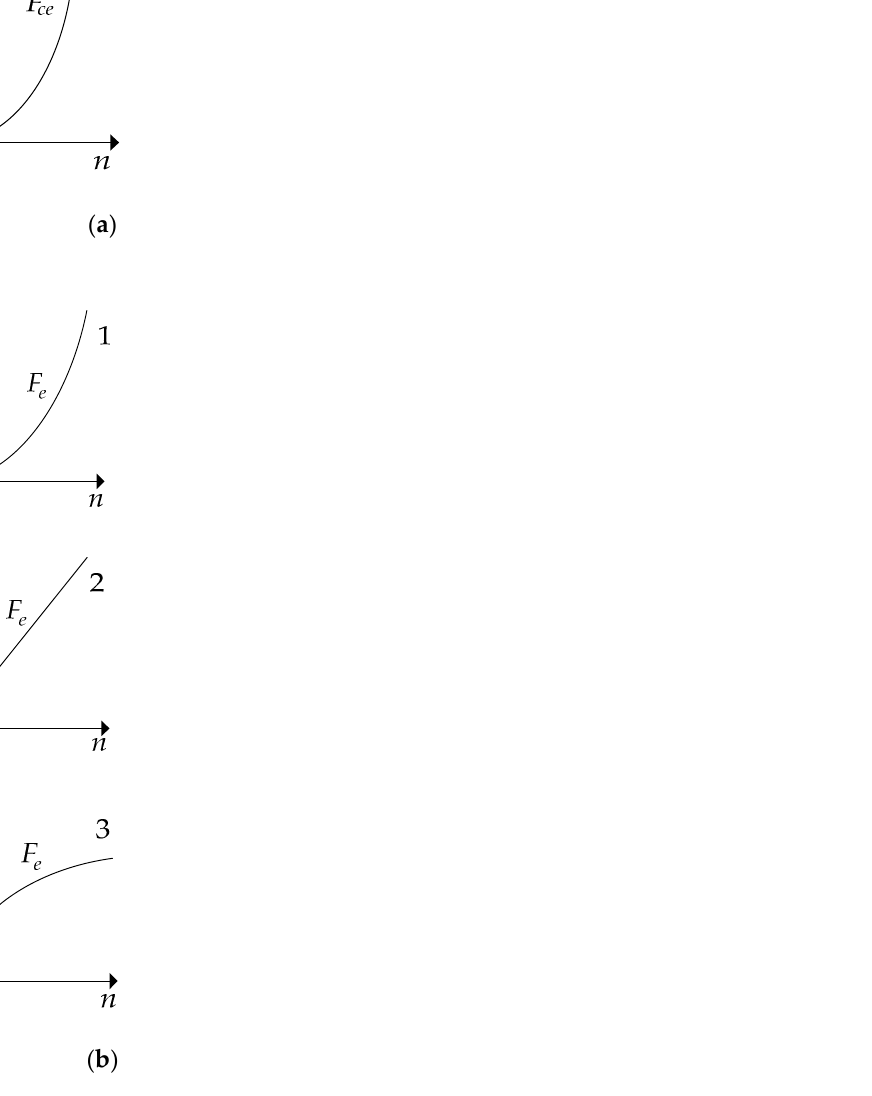
Figure 5. The force versus motor speed: ( a ) the centrifugal force F ce ; ( b ) the electromagnetic force F e (the curves from 1 to 3).